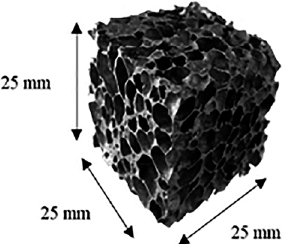
Figure 4. Image of A-242 aluminium alloy foam, showing the closed porosity attained with 0.75% TiH 2 at 948 K (A5).